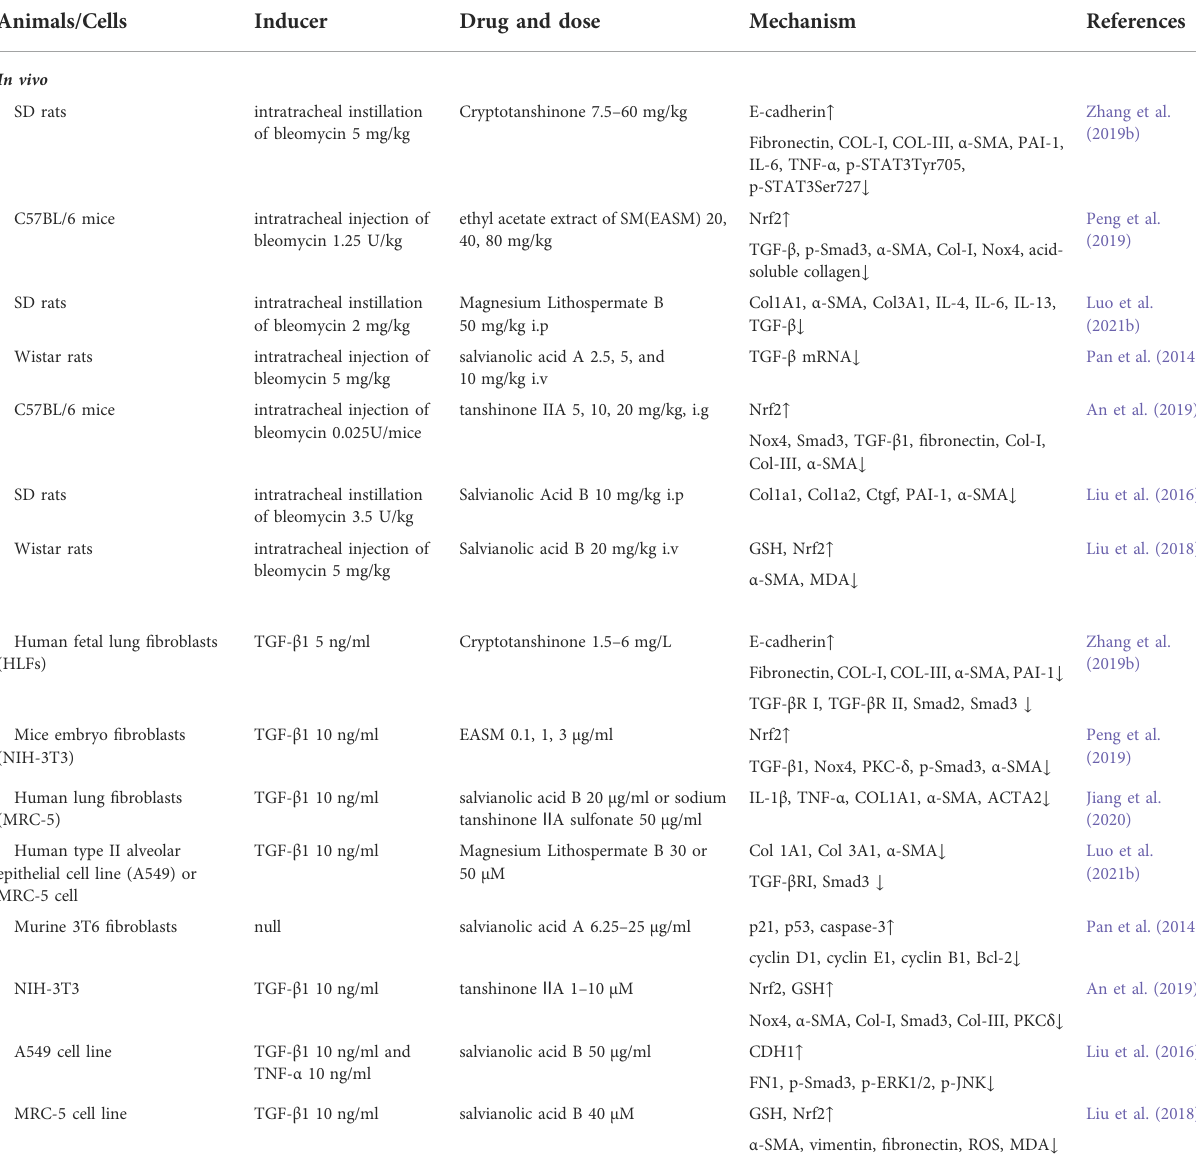
TABLE 3 Effects of SM and its active ingredients against pulmonary fi brosis in vivo and in vitro